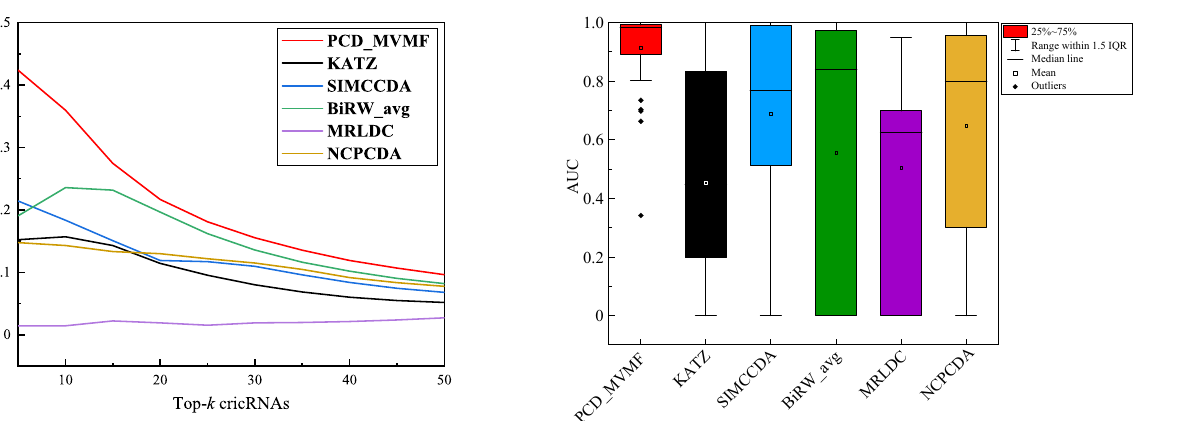
Fig. 7 AUC value distribution of PCD MVMF and other algorithms in predicting circRNAs for each single disease.